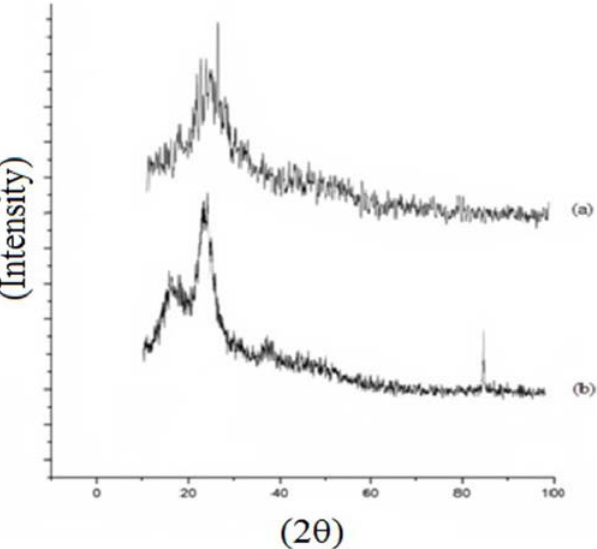
Fig. 5. XRD pattern of (a) PANI and (b) PANI nanocomposite, in aqueous